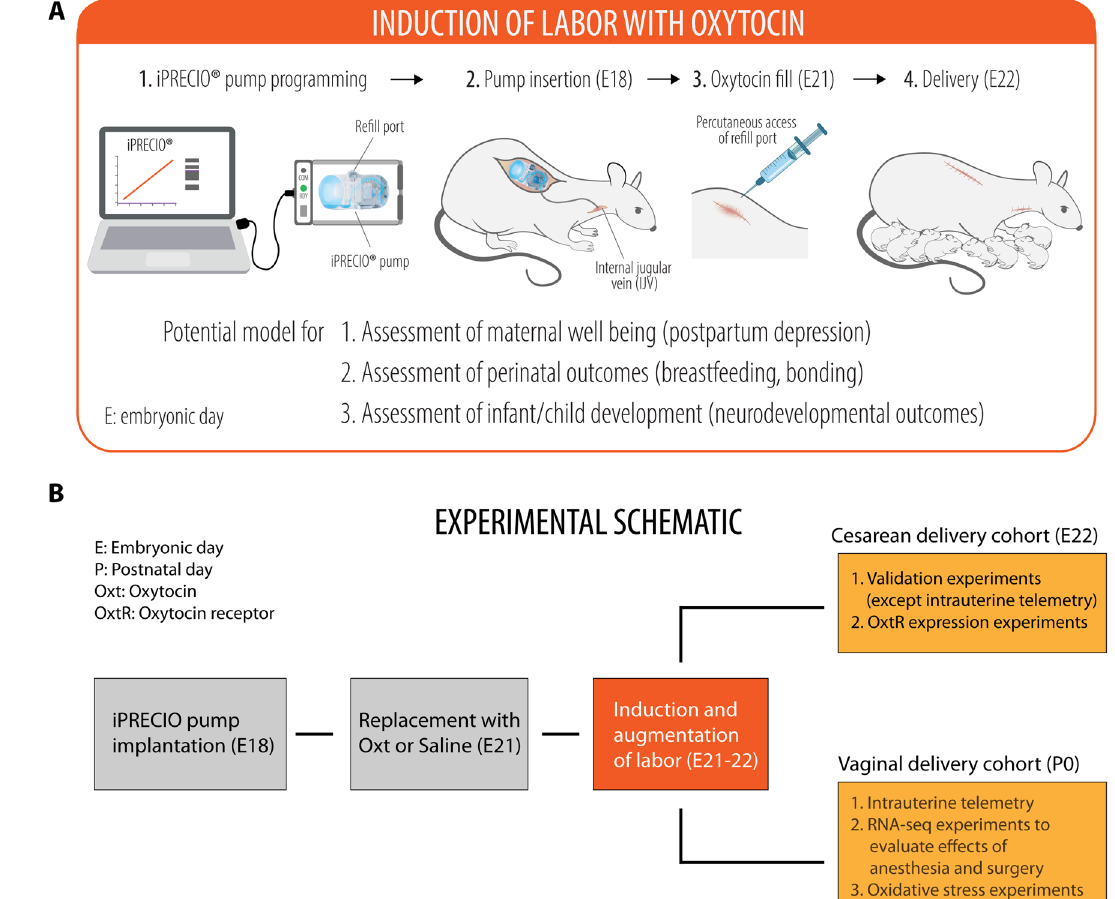
Figure 1. Experimental schematic for labor induction with oxytocin in term pregnant rats. ( A ) A cartoon depicting the programming and implantation of iPRECIO pump in a pregnant rat followed by birth of healthy pups. ( B ) Experimental schematic showing the overall experimental outline with two separate cohorts for cesarean and vaginal delivery. In the vaginal delivery cohort, there were three sets of independent experiments for (i) intrauterine telemetry, (ii) RNA-seq experiments to assess the impact of in utero exposure to anesthesia and surgery on the cortical transcriptome of the newborn brain, and (iii) examination of oxidative stress in newborn pups after either Oxt or saline,